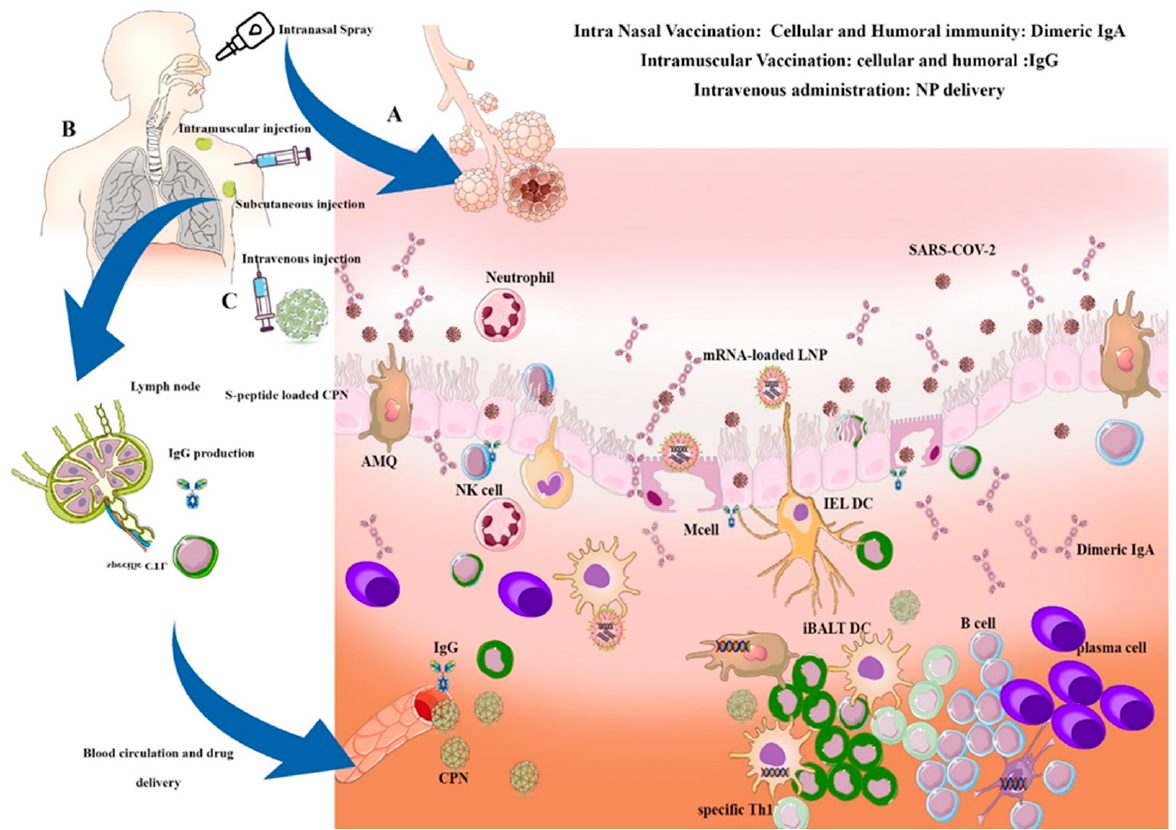
Figure 3. Mechanisms of vaccine administration using nanoparticles in VARID. ( A ) Intranasal vaccination: The aerosol- based nanoparticles containing the mRNA of virus antigen is transferred through the mucus layer into the nasal epithelial tissues by micro-fold cells (M cells) or passively through epithelial cell junctions. Nanoparticles are captured by DCs, and alveolar macrophages (AMQ) are passed by epithelial junctions and by other APCs, such as B cells. The mRNA of the antigen is translated into a specific peptide and presented to immature T cells, activating them and B cells. The activated B cells proliferate in the B cell zone to maturity and enter the systemic circulation to reach the inflammation site. IgA and B cells locally differentiate into antibody-secreting plasma cells to produce IgA dimers. The IgA dimers are secreted via polymeric Ig receptor (pIgR) at the mucosal surface. NALT/BALT immune response induces long-lasting B and T memory cells able to activate a rapid memory response [110]. ( B ) Other types of nano-vaccine injection, such as intramuscular, subcutaneous, and intravenous, can induce systemic reactions and IgG production, thus inducing lung protection. ( C ) Some specific nanoparticles induce the immunomodulatory responses using CPN, which can induce the IgG and specific CTL production against antigens. Systemic injection of nanoparticles can induce iBALT and local responses.